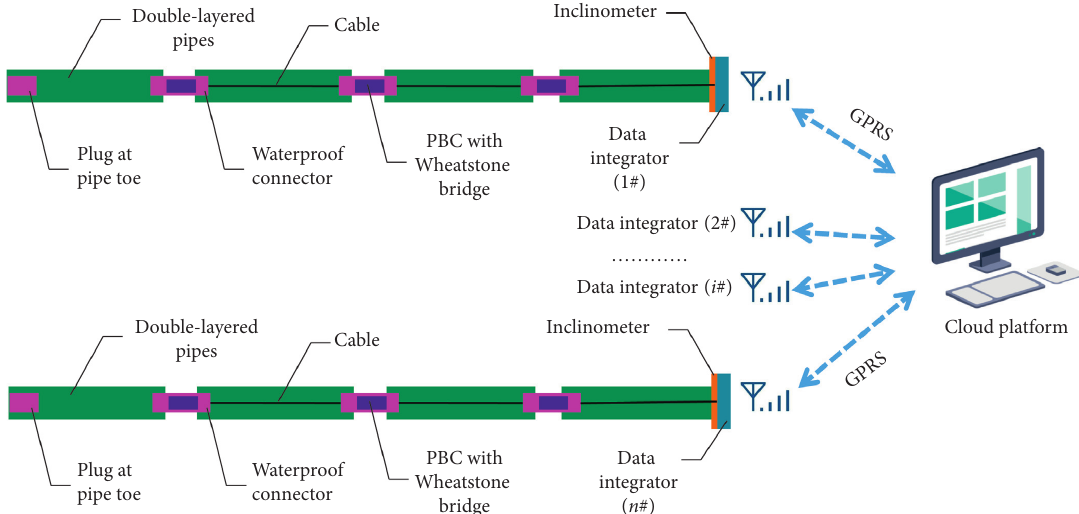
Figure 4: Schematic diagram of the assembly of special designed pipes and electronic